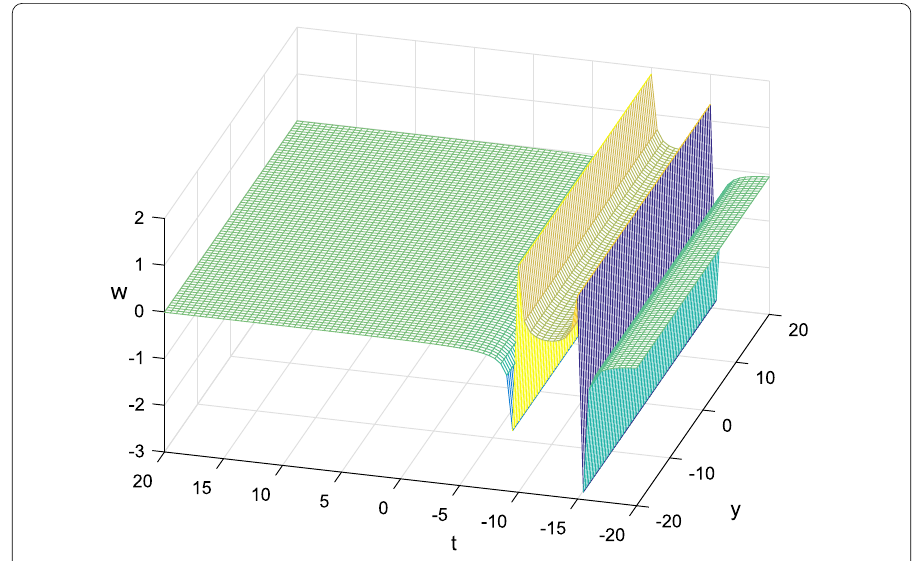
Figure 3 One-periodic solution plot of w ( t , y , n ) for z = 0.6, n = 2, η = 0.1, ˜ ζ 0 = 2, l = 4, p = 0.8, τ = 0.8 i , t ∈ [–15,15], y ∈